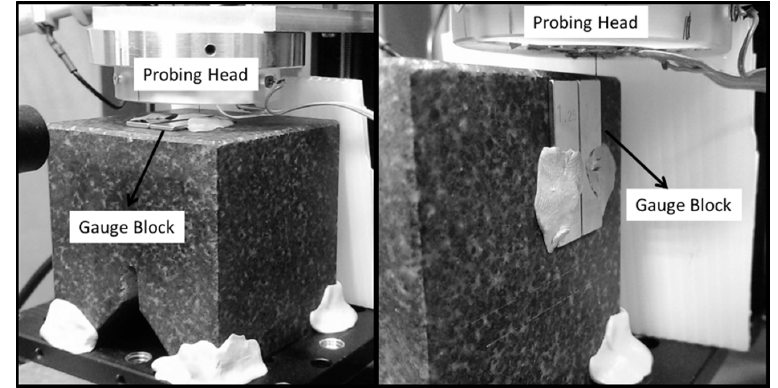
Figure 11. Gauge blocks mounted on the granite platform.